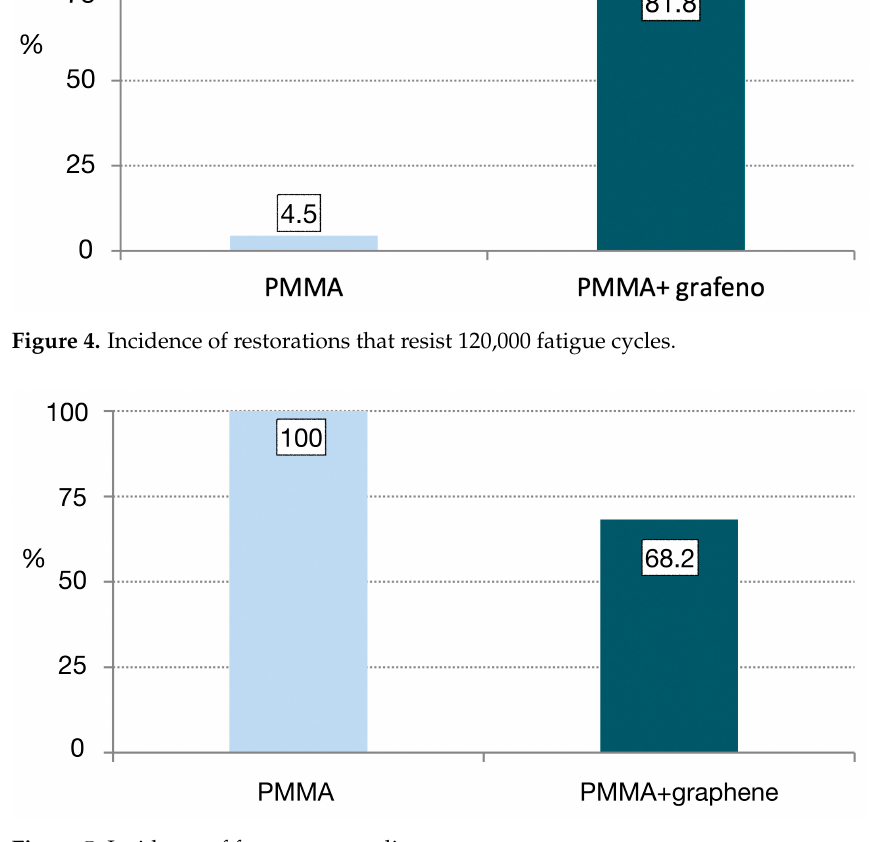
Figure 5. Incidence of fractures according to group.